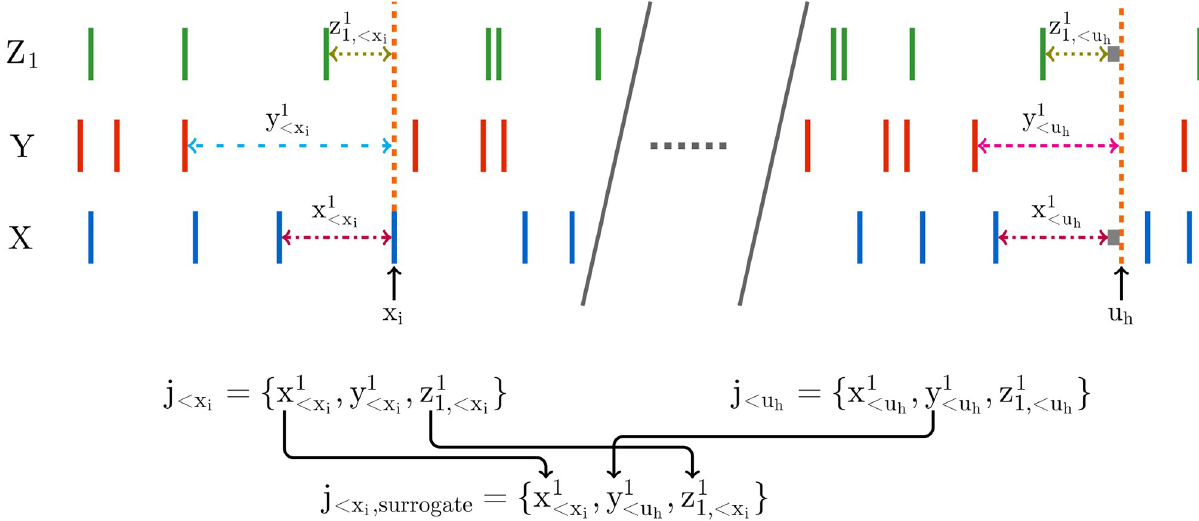
we find a j 2 J < U ; surr < x i < u h component of j and z component of j is similar to the z component of < u h < x i < u h < u h < x i and z components of j with the y component of j . Corresponding < x i < x i < x i < u h < u h